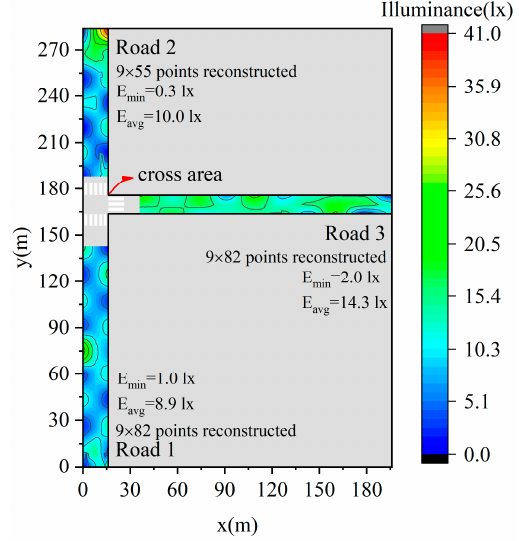
Figure 13. Illuminance reconstructions of three roads using linear function in the transverse direction and sine function in the longitudinal direction.